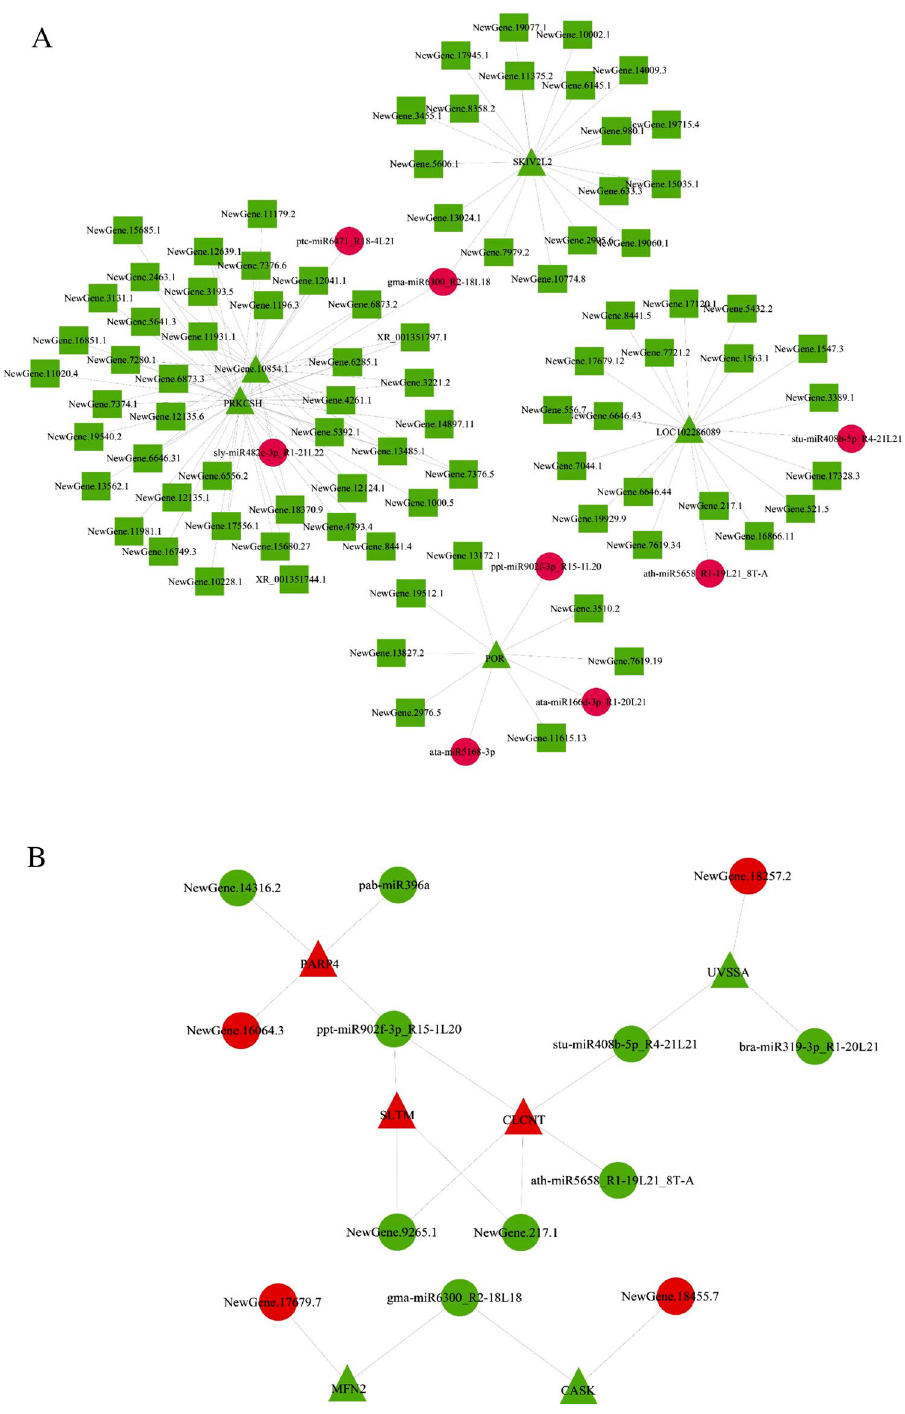
Figure 4. Network of core RNAs in the comparison between yaks and cattles ( A ) and the comparison among yaks living at three different altitudes ( B ). Triangular nodes represent mRNAs; circular nodes represent miRNAs; square nodes represent lncRNAs. Red nodes represent the up-regulated, and the green ones represent the down-regulated transcripts. The network were analyzed using the miRanda software and were visualized by the Cytoscape V3.2 software (http:// cytos cape.